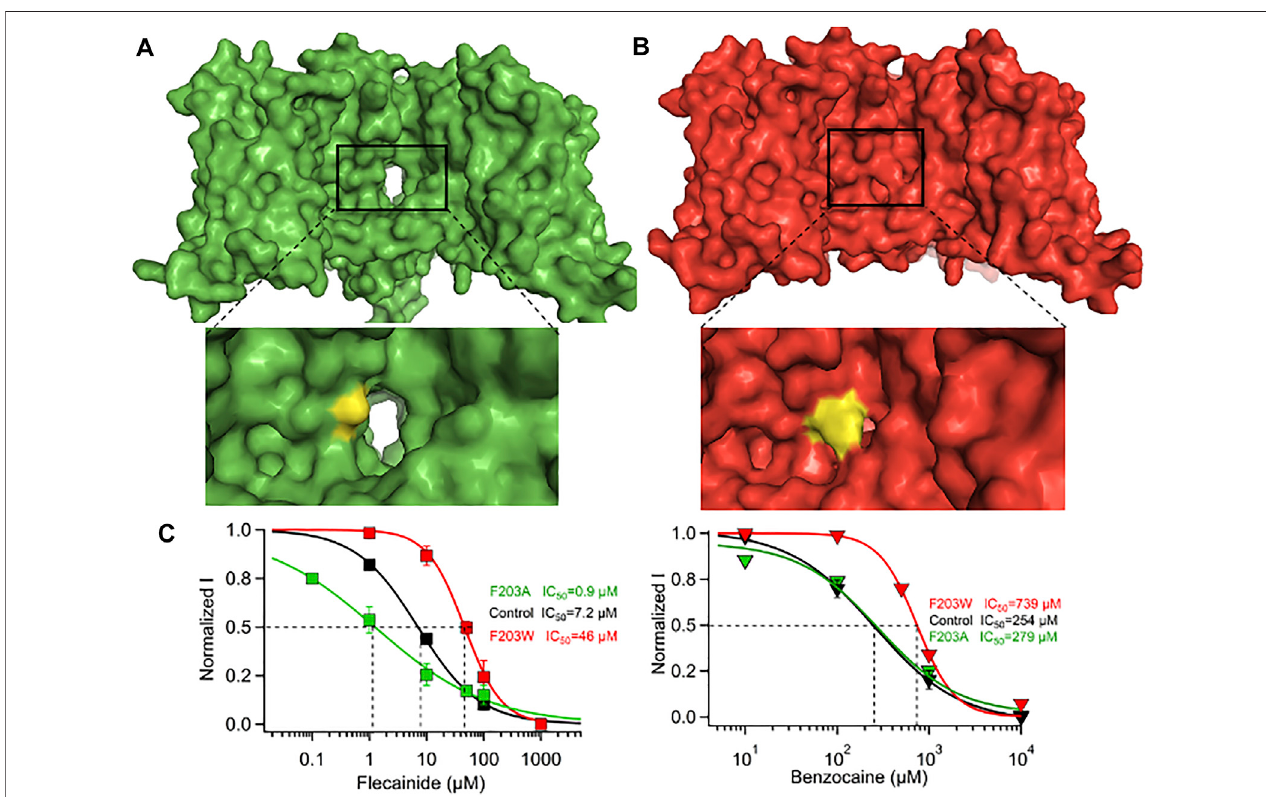
FIGURE3| EffectofF203A/WmutationsonthesizeandfunctionalityofNa v Ab. (A) F203Amutationenlargesthefenestrationssigni fi cantlyandcausesasigni fi cant leftwardshiftinthesteady-stateinactivationpro fi le. (B) F203Wmutationnarrowsthefenestrationssigni fi cantlyandcausesasigni fi cantrightwardshiftinthesteady-state inactivation pro fi le. (C) Effect of F203A and F203W on the potency of fl ecainide (left) and benzocaine (right) (Gamal El-Din et al., 2018b).